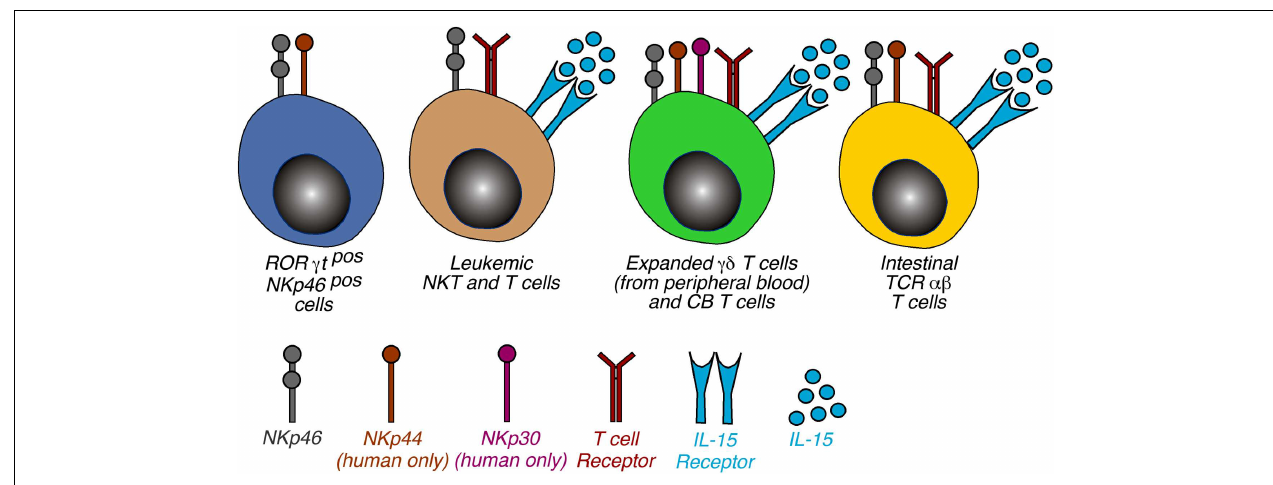
expression is also indicated. Of note, the mechanisms involving the triggering ofTCR and γ c cytokines are a common feature of NCR induction of NCRs onT lymphocytes. Abbreviations: CB, cord blood; IELs, intraepithelial